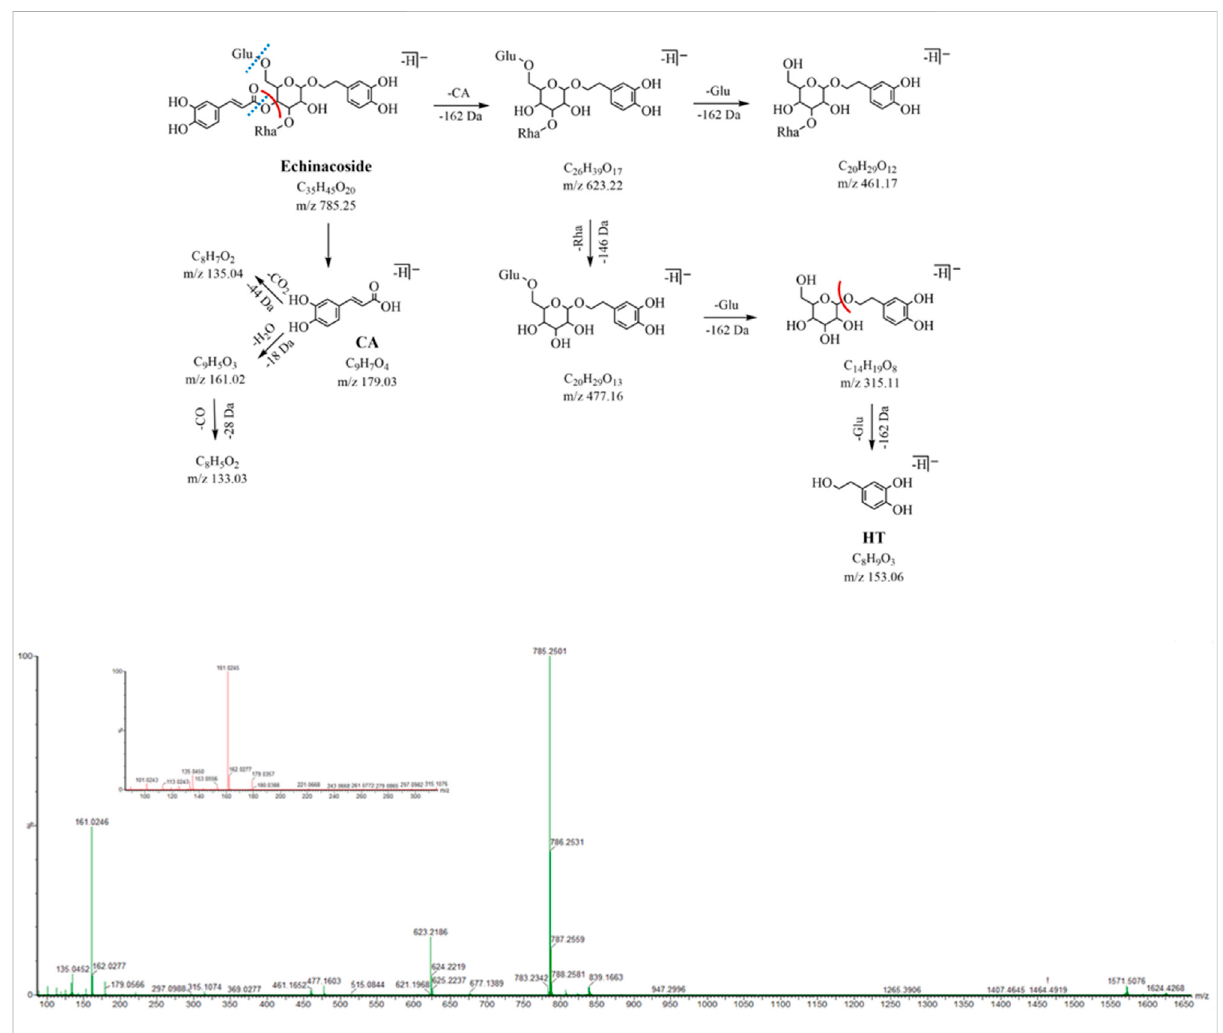
FIGURE 5 MS 2 and the fragmentation pathway of the